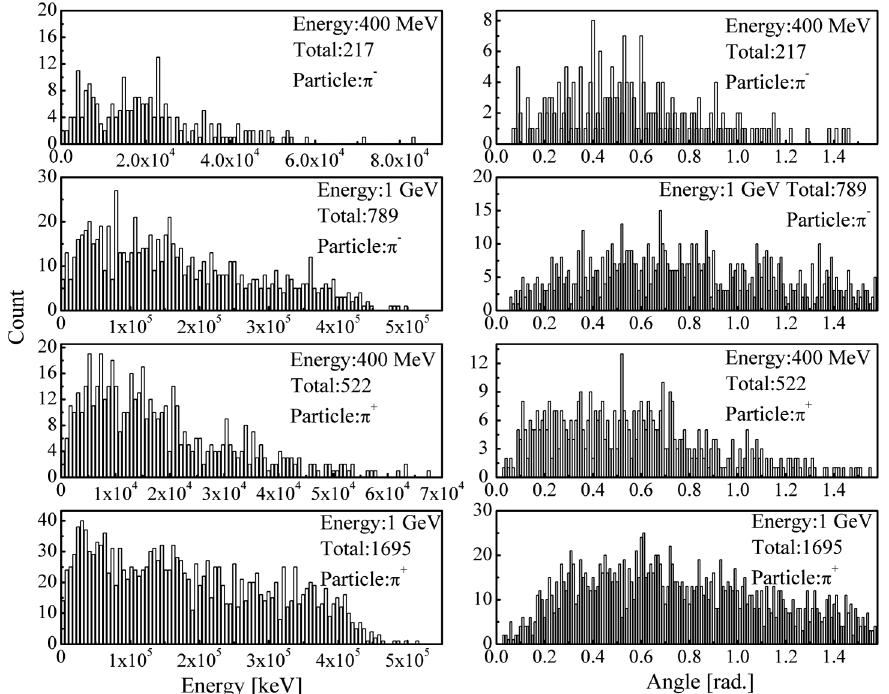
FIG. 3. Energy and angular spectra of pions produced at the